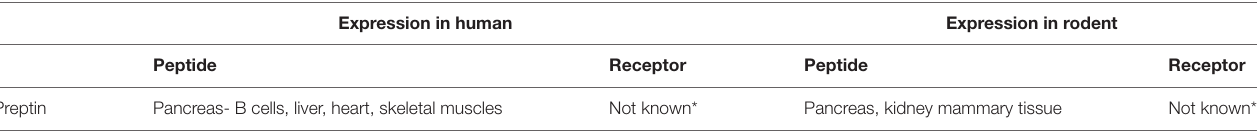
TABLE 2 | Expression of the preptin and preptin receptor in humans and